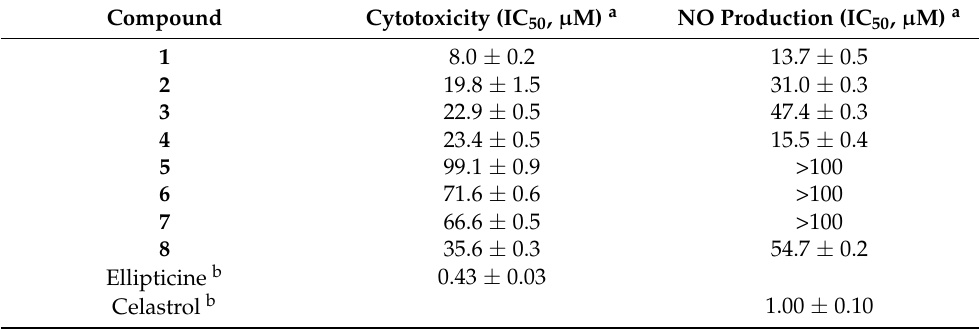
Table 3. Cytotoxicity against Hep G2 cells and inhibition of NO production in macrophage RAW 264.7 cells of 1 – 8